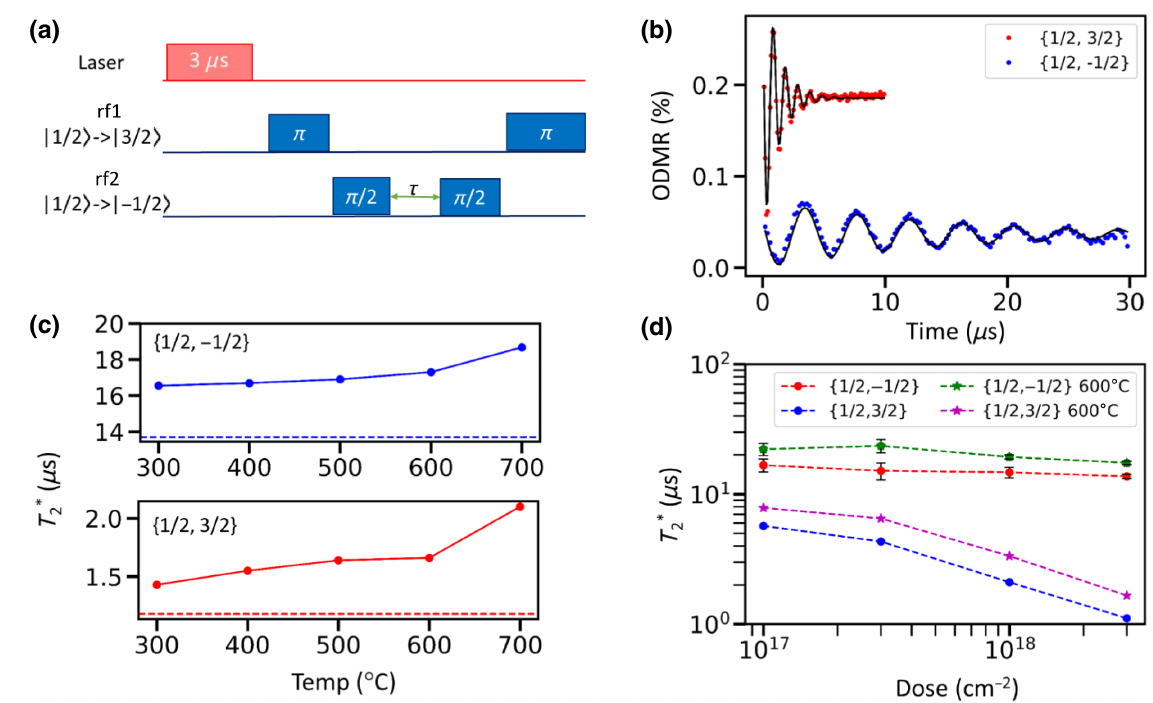
FIG. 5. Suppression of strain-induced dephasing. (a) rf and optical pulse sequence for Ramsey interferometry in the { 1/2, − 1/2 } basis. The pulse lengths for the rf1 π pulse and rf2 π /2 pulse were 1.2 µ s and 300 ns, respectively. The rf2 frequency was intentionally detuned by approximately 200 kHz from resonance to produce slowly oscillating Ramsey fringes. (b) Ramsey fringe coherence at low = 1.2 µ s in the { 1/2, 3/2 } basis (red) and 13.7 µ s in the field (0.3 mT) in different bases for the same isopure sample (3 × 10 18 cm − 2 ). T ∗ 2 { 1/2, − 1/2 } basis (blue). (c) T ∗ in the { 1/2, − 1/2 } basis (upper) and { 1/2, 3/2 } basis (lower) for the isopure, 3 × 10 18 cm − 2 sample after 2 of the unannealed sample of equal dose in each respective annealing for 2 h at various temperatures. The dashed lines indicate the T ∗ 2 of isopure samples versus dose for the two bases. Dots indicate the unannealed samples while stars indicate basis. (d) Comparison of T ∗ 2 samples annealed at 600 °C for 2 h. Error bars are given to show one standard deviation of the fits in the { 1/2, − 1/2 } basis (the standard deviations in the { 1/2, 3/2 } basis are smaller than the marker